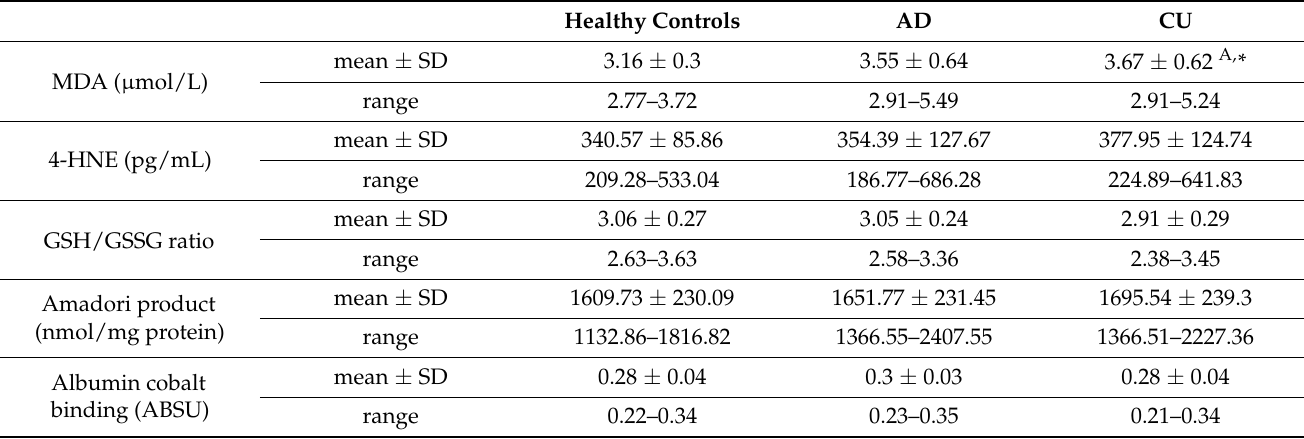
Table 2. Markers of oxidative stress in healthy controls and patients with AD or CU a .